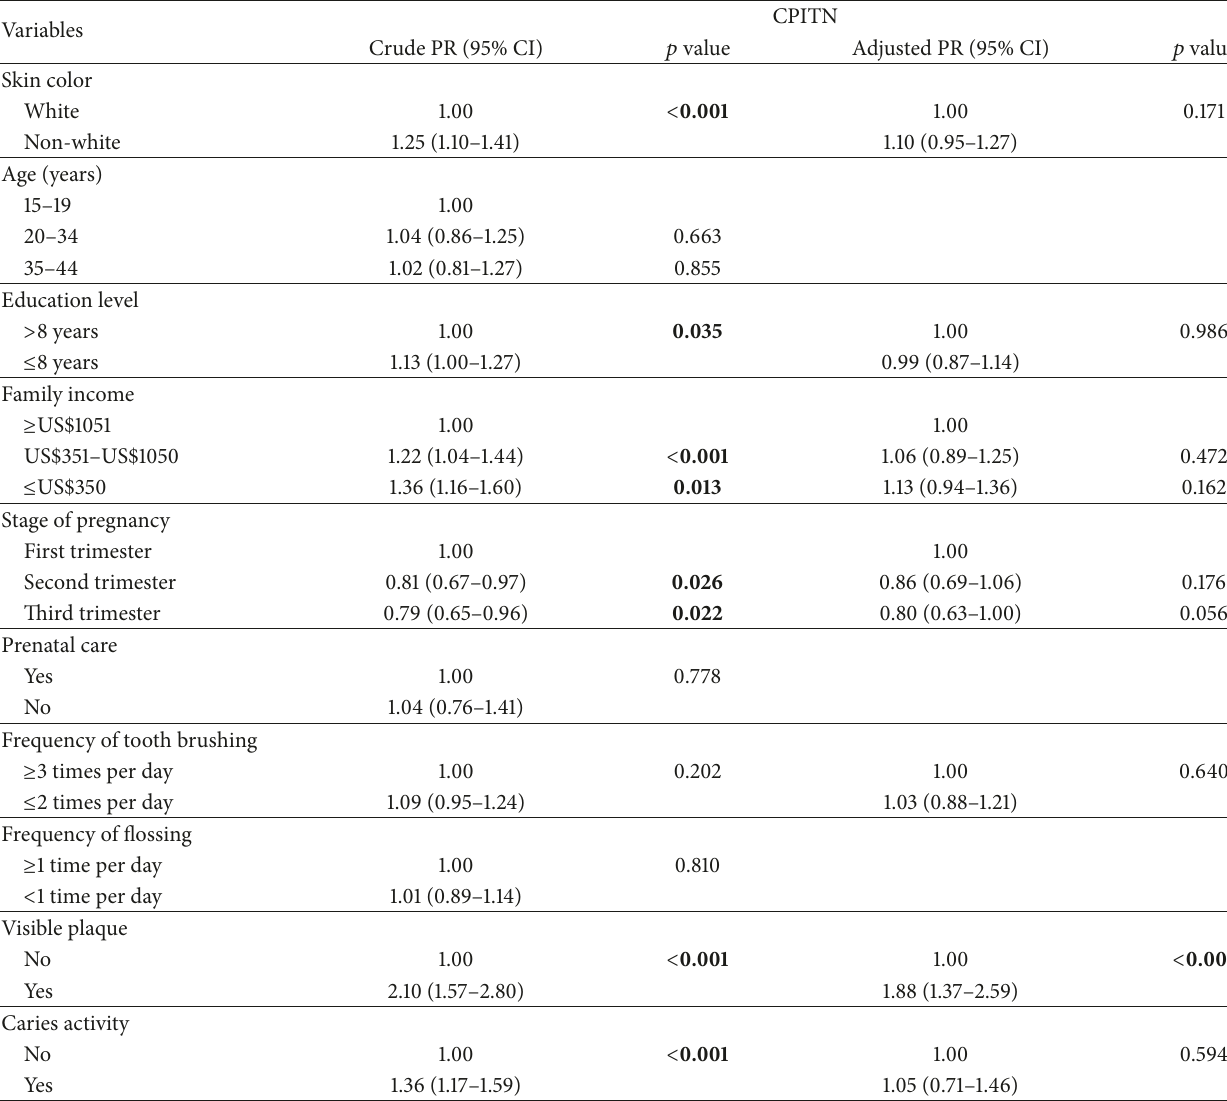
Table4:Crudeandadjustedanalysis[prevalenceratio(PR)]fortheassociationbetweenindependentvariablesandCPITNscoresinpregnant